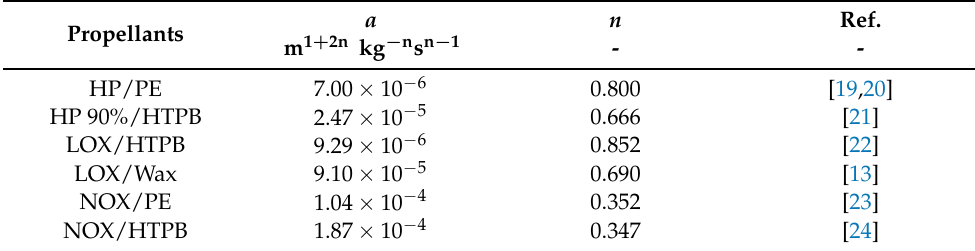
Table 1. HREs propellant combinations. PE and HTPB stand for PolyEthylene and Hydroxyl- Terminated PolyButadiene, respectively.